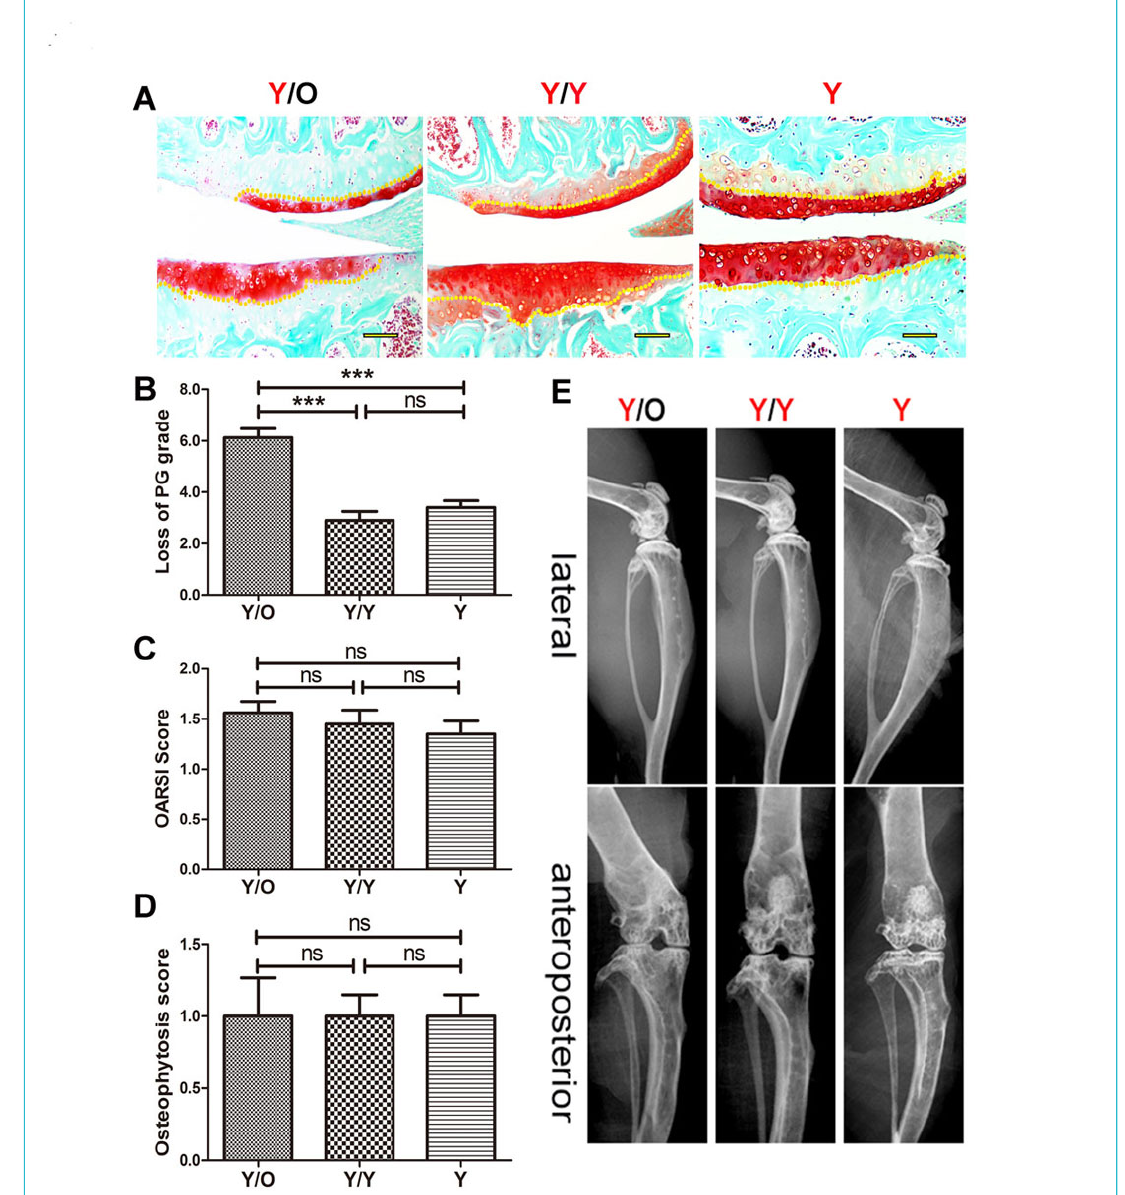
Figure 2: Histological and radiographic changes in cartilage of young mice in the Y/O, Y/Y and Y groups. (A) PG decrease in young cartilage from the Y/O group was greater than that from the two other groups and histological scores in the Y/O group were relatively higher. Represen- tative images are shown (8 Y/O mice, 10 Y/Y mice and 10 Y mice were used) Scale bar = 500 μm. (B) Loss of cartilage (proteoglycan grade) in young mice from the Y/O group was significantly greater compared to the Y/Y and Y groups. The area covered from the surface of the carti- lage to the yellow dotted lines indicates the proteoglycan content. (C) There was no statistically significant difference in OARSI score among the three groups (p >0.05). (D, E) No significant pathological changes were detected in the micro-X-ray. The presence and severity of osteope- nia and sclerosis among the three groups were not evident in this study, and osteophytosis was detected at the margins of the knee joint in young mice from the three groups. There was no statistically significant difference in osteophytosis scores among the three groups (p >0.05). The differences of the proteoglycan content, the Osteoarthritis Research Society International (OARSI) score and the osteophytosis scores among three groups were assessed by one-way ANOVA with Tukey’s post-hoc test.*** p <0.001. Values are presented as mean ± standard er- ror of the mean. ns = not significant; O = old; Y =